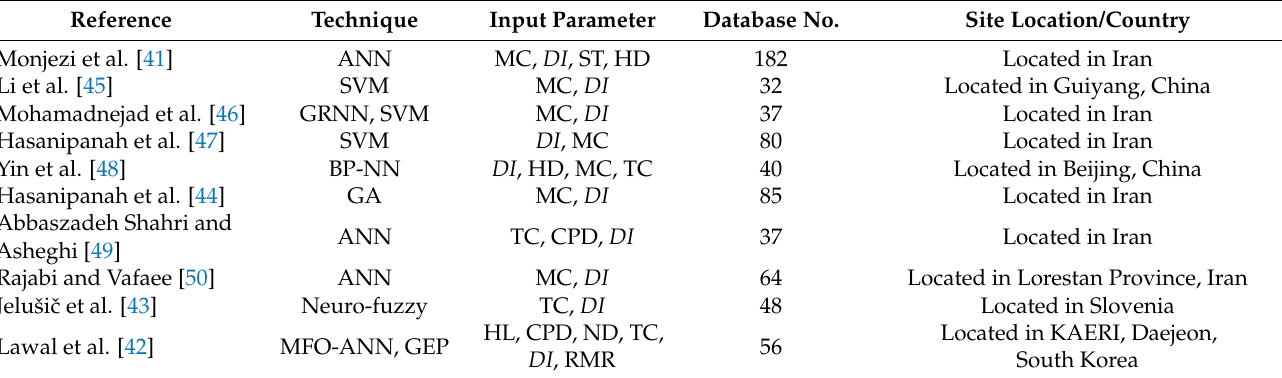
Table 1. Some relevant investigations for predicting tunnel blast-induced